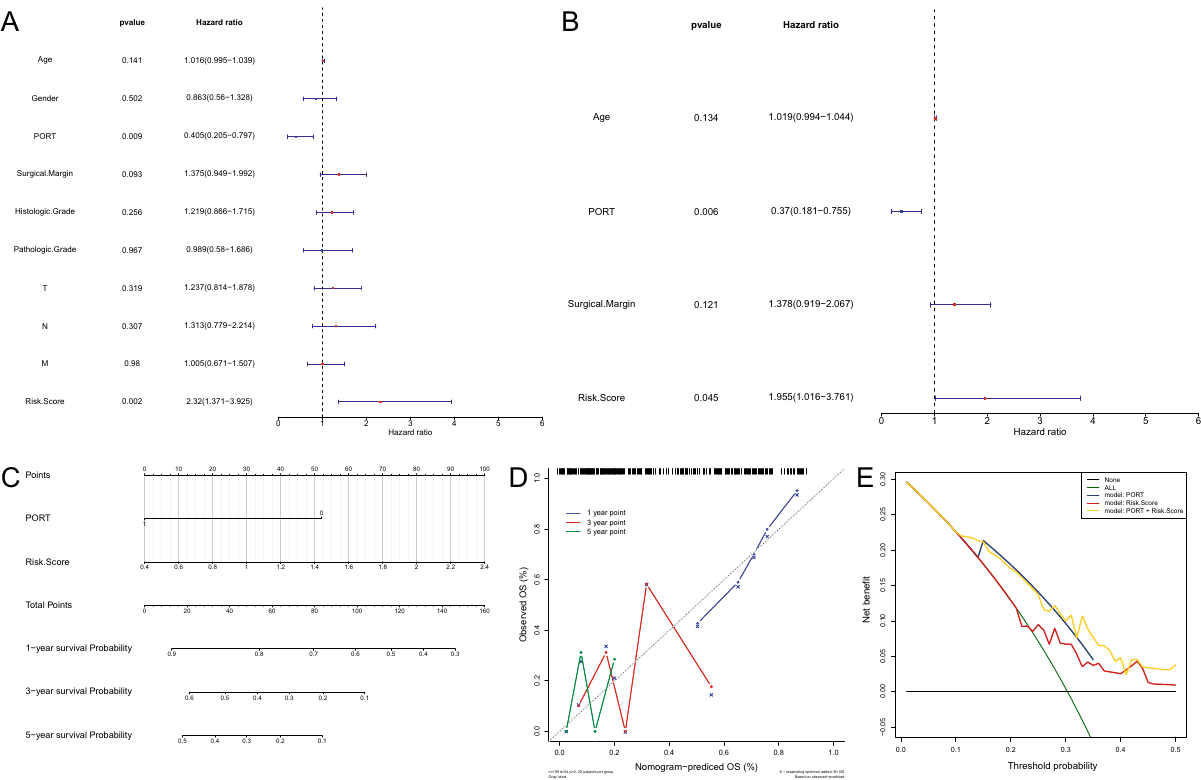
Figure 4. Construction of a predictive nomogram. ( A , B ) Hazard ratio and P value of the constituents involved in univariate and multivariate Cox regression considering clinical parameters and Risk Score in PDAC. ( C ) Nomogram to predict the 1-year, 3-year, and 5-year overall survival rate of PDAC patients. ( D ) Calibration curve for the overall survival nomogram model in the discovery group. A dashed diagonal line represents the ideal nomogram. ( E ) DCA curve was established to evaluate the clinical utility and benefit of the nomogram and additional